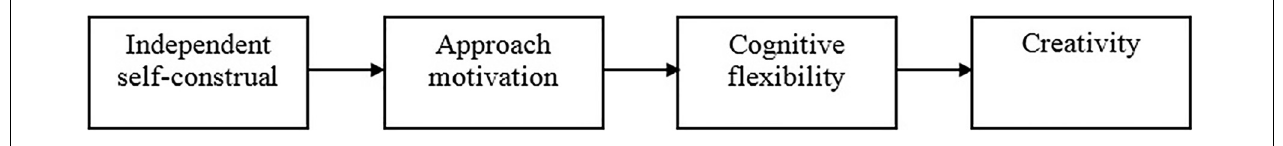
FIGURE 1 | Linking self-construal to creativity: A three-stage mediation model.